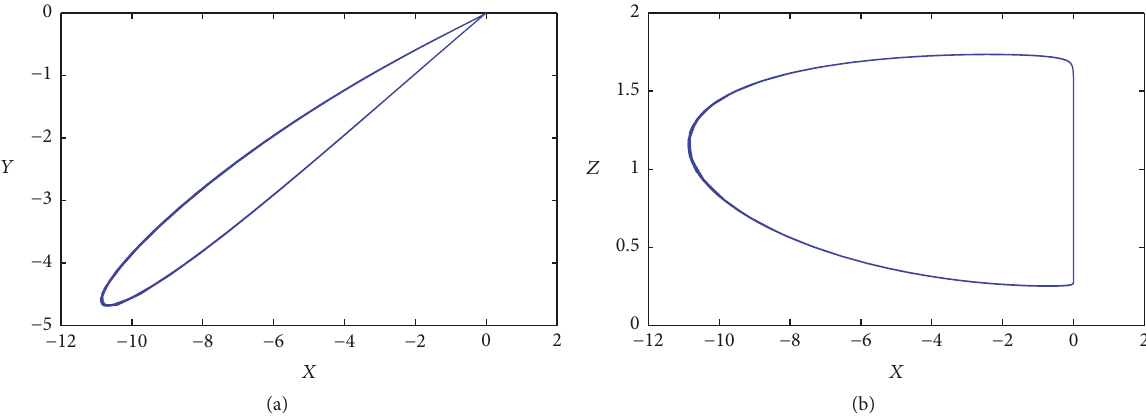
Figure 7: The solution on a phase diagram for 𝛼 = 500 , 𝑅 = 75 , 𝜎 1 = 6.2 , and 𝜂 = 3 . 𝑌 versus 𝑋 (a) and 𝑍 versus 𝑋